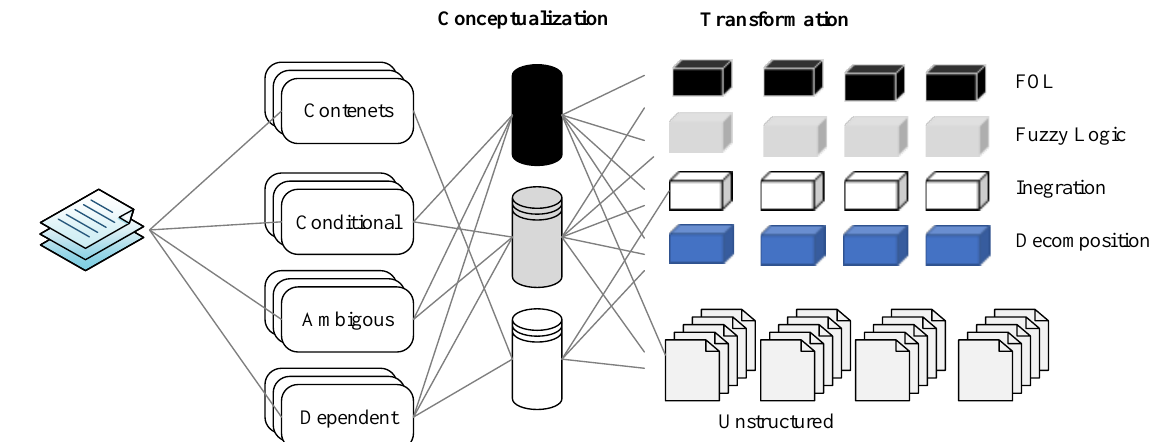
Buildings 2019 , 9 , x FOR PEER REVIEW Figure 2. Overview of the Transformation Reasoning Algorithm (TRA). Figure 2. Overview of the Transformation Reasoning Algorithm (TRA).